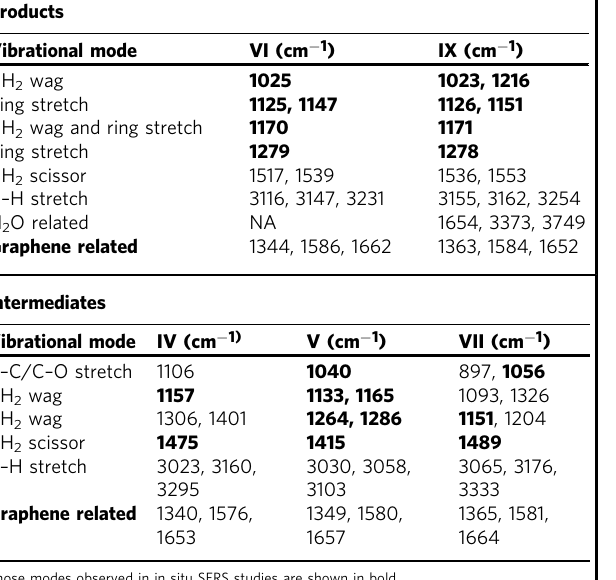
Table 1 Raman mode frequencies computed for reaction products and selected intermediates from reaction schemes in Fig.